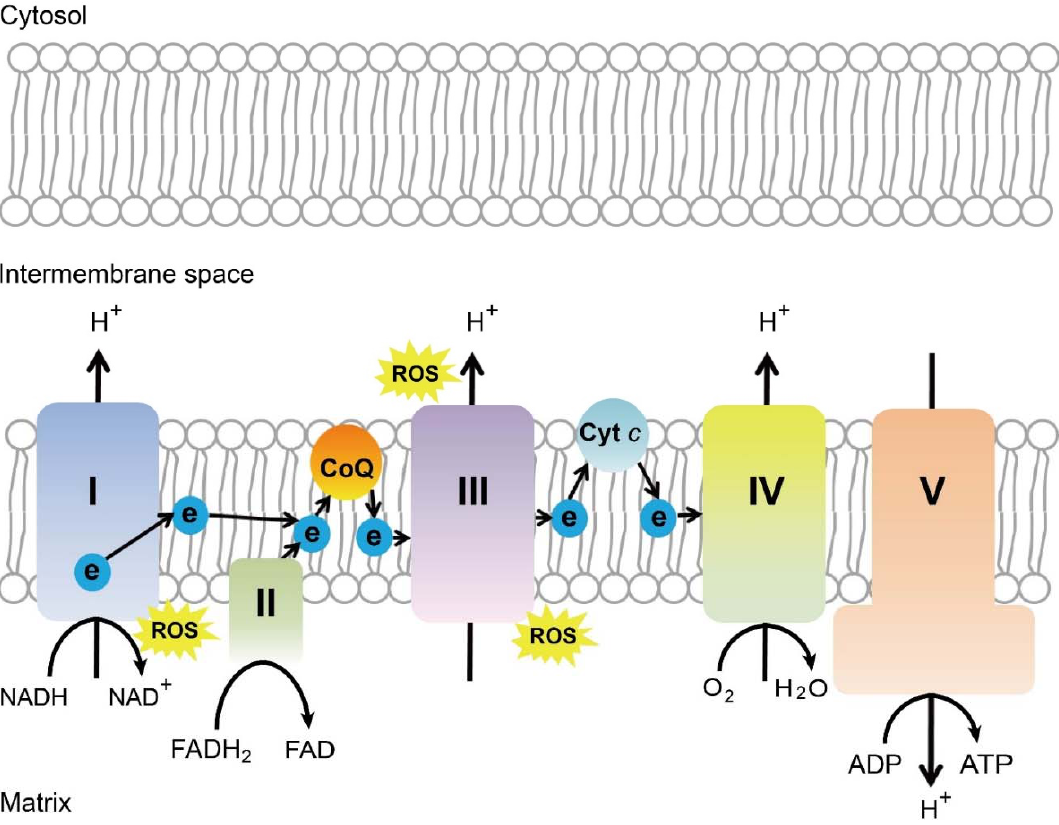
Figure 3. Schematics of mitochondrial electron transport chain. ROS, reactive oxygen species, ATP, adenosine triphosphate, CoQ, coenzyme Q, Cyt c , cytochrome c , Complex I, NADH coenzyme Q reductase, complex II, succinate dehydrogenase, complex III, cytochrome bc 1 complex, complex IV, cytochrome c oxidase, complex V, ATP synthase. Schematics were drawn by Dr. Zhongjie Fu, Ophthalmology, BCH. Adapted from EMBO Mol Med (2019)11: e10473.